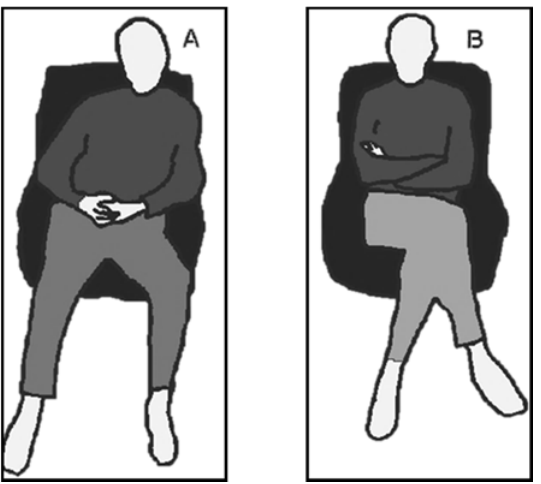
Figure 1. Visual depictions of the open ( A ) and closed ( B ) postures presented to